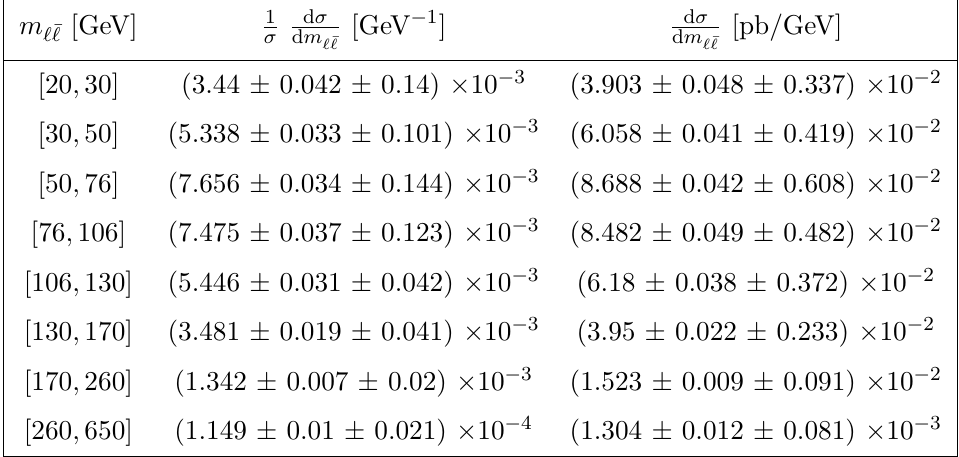
Table 38 . The measured di(cid:11)erential cross section and bin boundaries for each bin of the normalized and absolute measurements of the tt di(cid:11)erential cross section at particle level in the (cid:12)ducial phase space as a function of m are tabulated. ‘ (cid:22) ‘